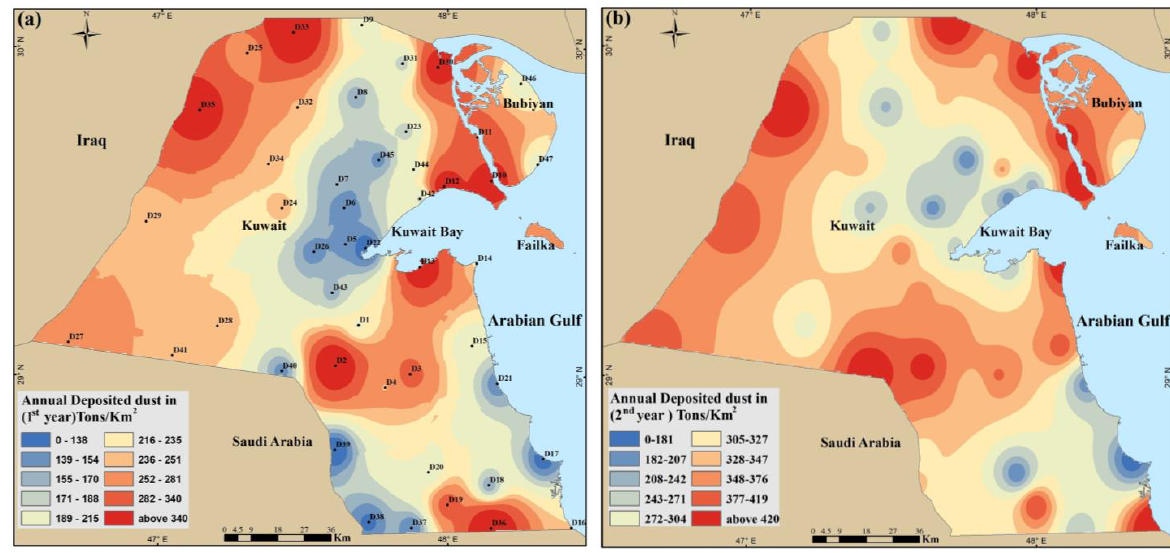
Figure 8. Kuwait annual deposited dust amounts in (tons/km 2 ) for two years from the 1st of September to the 31st of August ( a , b ). Table 2. The average number of SDS days in the Middle East hotspot area (A) compared to its